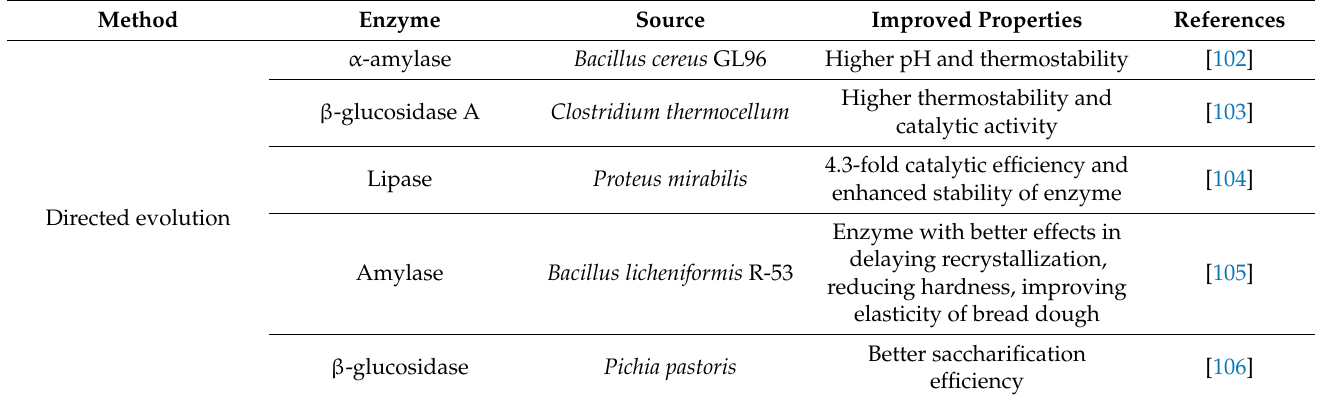
Figure 5. The schematics of different enzyme engineering methods. The enzymatic diversity created by these methods through the application of semi- rational designs based on artificial intelligence, protein structure, and sequence information yields superior specificity and functionality of industrial enzymes. Different approaches for the enzyme engineering are presented in Table 2. Table 2. Different enzyme engineering strategies and engineered biocatalysts.